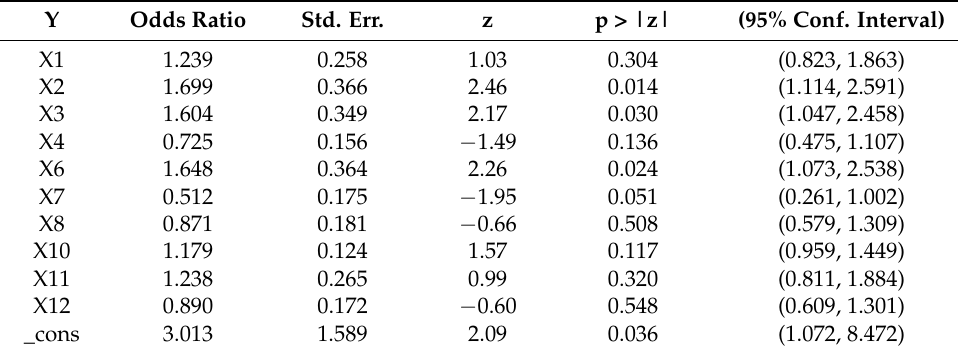
Table A4. The third step of stepwise logistic